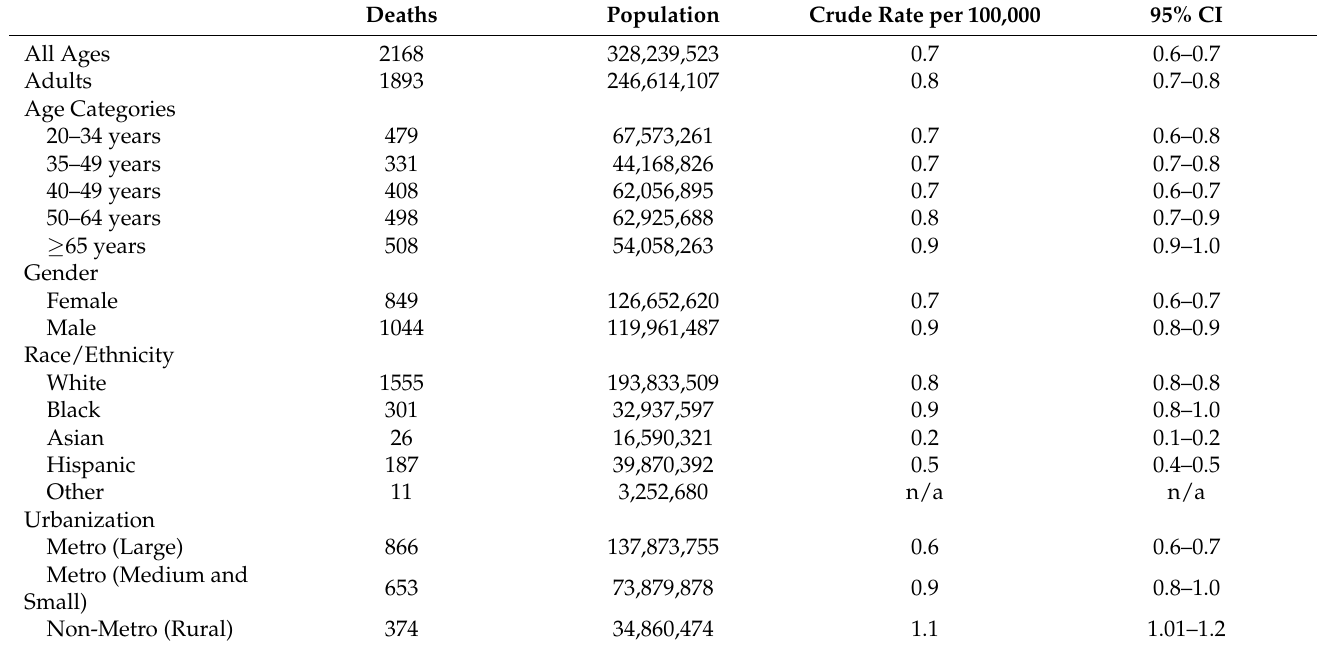
Table 2. Adults with cerebral palsy who died in 2019, with the underlying cause of death listed as “cerebral